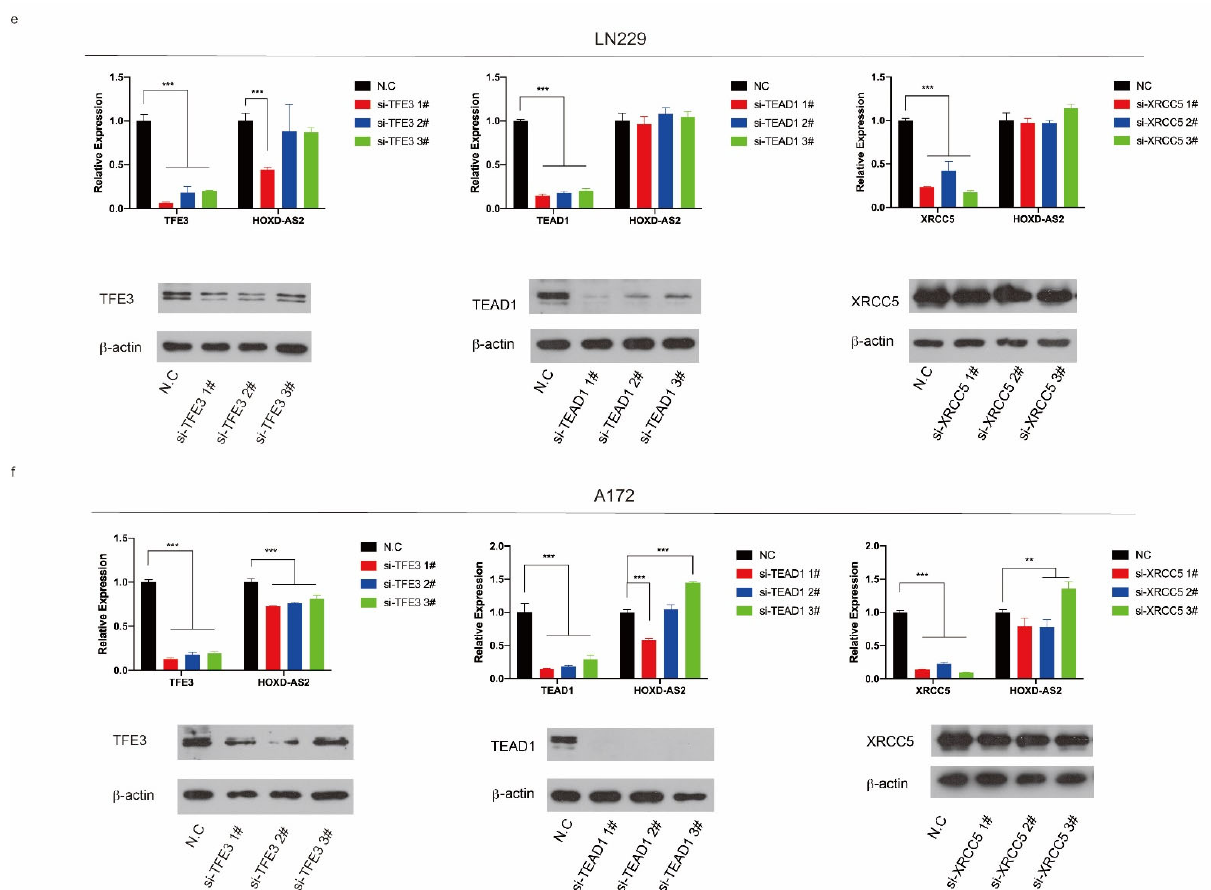
Figure 2. Overexpression of HOXD ‐ AS2 in glioblastomas was associated with transcriptional activation. ( a , b ) Absolute quantitative PCR in gene level ( a ) and transcription level ( b ). ( c ) The promoter region of HOXD ‐ AS2 transcriptional activity was detected by luciferase report assay in astrocyte cell HA ‐ sp and glioblastoma cell lines LN229, A172 and U87MG. ( d ) DNA ‐ pull down/MS assay was used to find the factors which binding to the HOXD ‐ AS2 promoter. Flow chart provided for screening of potential transcription factors regulating HOXD ‐ AS2 . ( e , f ) The expression of HOXD ‐ AS2 was detected by RT ‐ qPCR and Western blot after transfecting with TFE3 / TEAD1 / XRCC5 siRNAs in LN229 ( e ) and A172 ( f ). Data are presented as the mean ± SEM from three independent experiments. Significant results were presented as ** p < 0.01, *** p < 0.001. Two ‐ tailed Student’s t ‐ test was used in ( d ). ( e , f ) were analyzed by ANOVA.